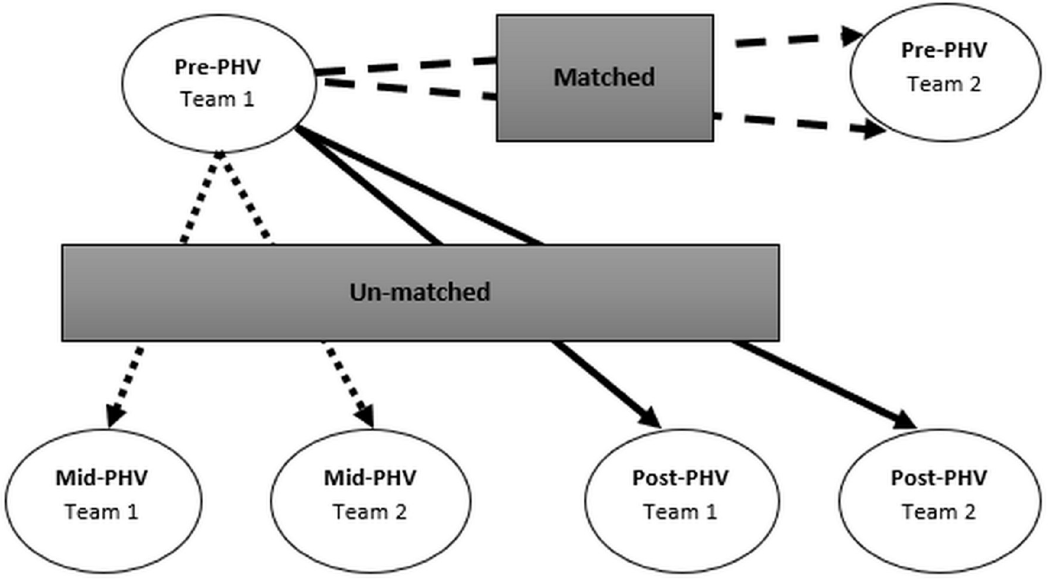
Fig 1. Schematic representation of game situations (Pre-PHV